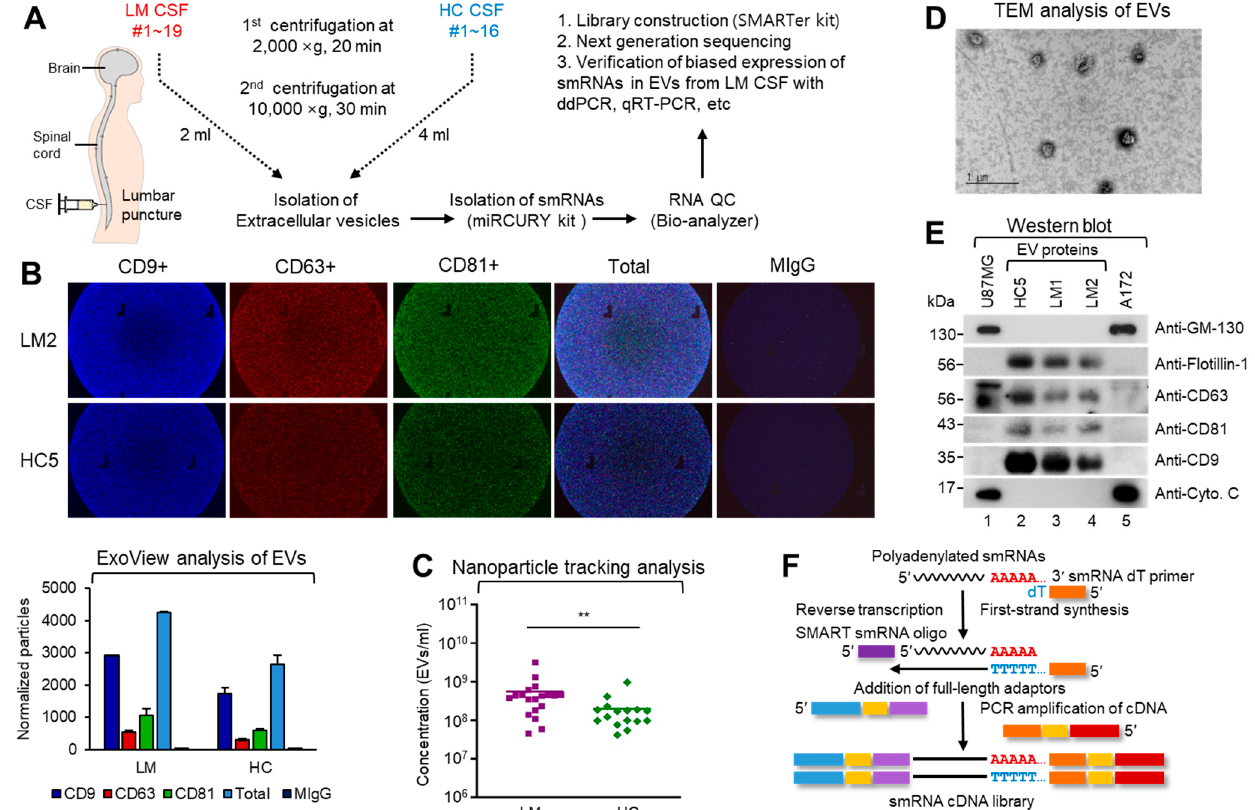
Figure 1. Biochemical and molecular characterization of EVs from CSF of LM patients. ( A ) Brief schematic flowchart and analytical procedure for patient sample collection, smRNA preparation, library construction, NGS, and biochemical analysis of EVs from CSF of LMs and HCs. CSF samples were obtained from patients harboring leptomeningeal metastasis, from intraventricular puncture ( n = 12), cisternal puncture ( n = 6) or lumbar puncture ( n = 17). ( B ) The relative expression of EV specific markers was measured using ExoView R100 platform and Tetraspanin kit. CSF samples were incubated with the mixture of CD9-, CD63-, and CD81-capture antibodies on the Tetraspanin chip. After washing with washing buffer, the fluorescence images of chips were obtained with the confocal microscopy-based camera. Each antibody conjugated particles in 50-200 nm size were measured with the ExoView built-in software (bottom; bar graphs). Mouse IgG (MIgG) was used for negative control. The data represent the mean values of three independent experiments ( n = 3) and error bars in the graph represent ± standard deviation. ( C ) Nanoparticle tracking analysis (NTA) revealed the difference in the EV concentrations between LM (purple rectangle, n = 19) and HC (green rhombus, n = 16). NTA was repeated 3 times per sample and an average value was provided ( n = 3, two-tailed t -test, ** p < 0.01). ( D ) Transmission electron mi- croscopy (TEM) shows bi-membranous vesicles of purified CSF EVs. scale bar: 1 µm. ( E ) Western blot analysis of EV markers (Flotillin-1, CD63, CD81 and CD9) and cellular proteins (GM-130 and cytochrome C in U87MG and A172 glioma cells) in HC and LM CSF EVs. ( F ) Schematic representation cDNA synthesis procedure of SMARTer smRNA-Seq method. Priming of a polyadenylated smRNA by a 3 ′ smRNA dT primer is followed by the synthesis of the first-strand cDNA by a MMLV-derived reverse transcriptase (RT). Extension and template switching then allows for a complete single stranded cDNA. PCR amplification allows for the addition of library adaptors and the synthesis of second-strand cDNA.